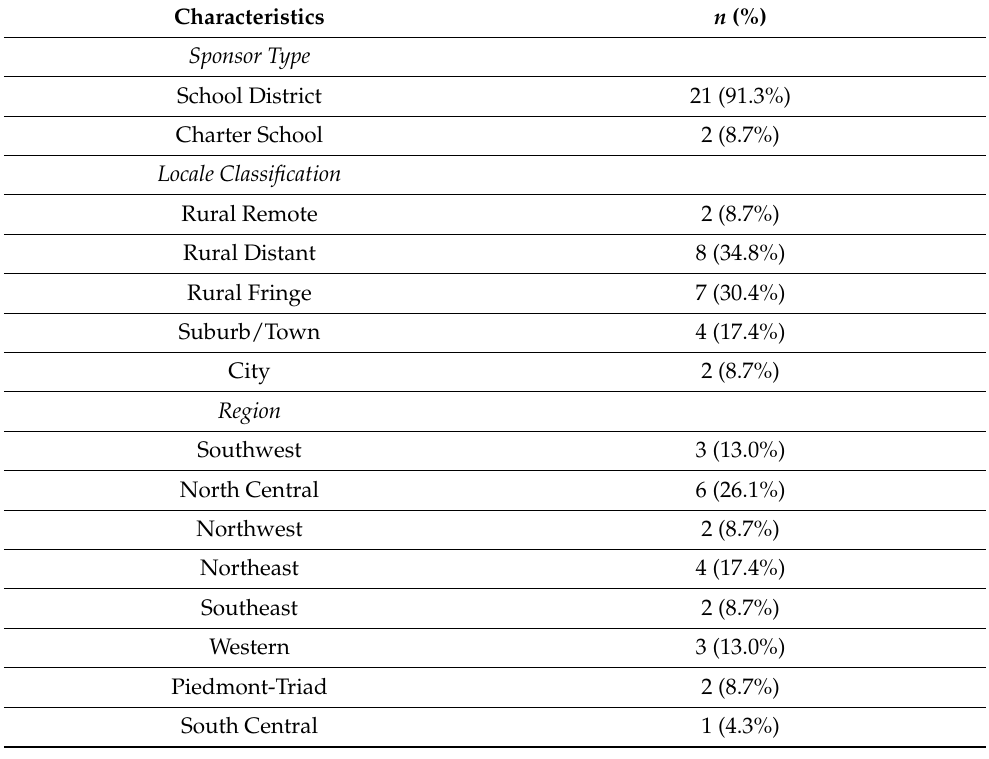
Table 1. Characteristics of districts and charters represented by participating school nutrition directors ( n =